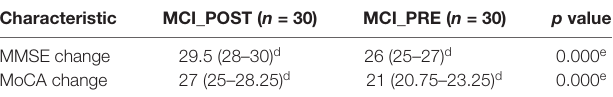
TABLE 2 | Cognitive scores of MCI patients pre- and post-moxibustion treatment.